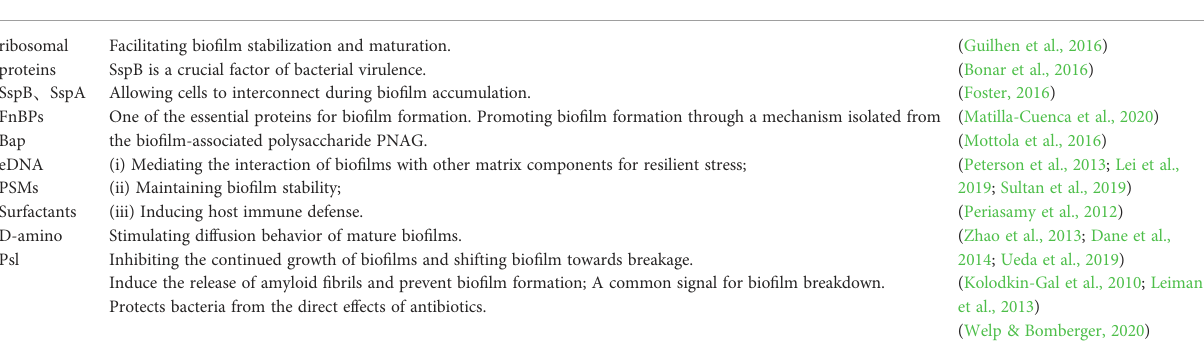
TABLE 2 Factors associated with bio fi lm maturation and diffusion. Factors Effects